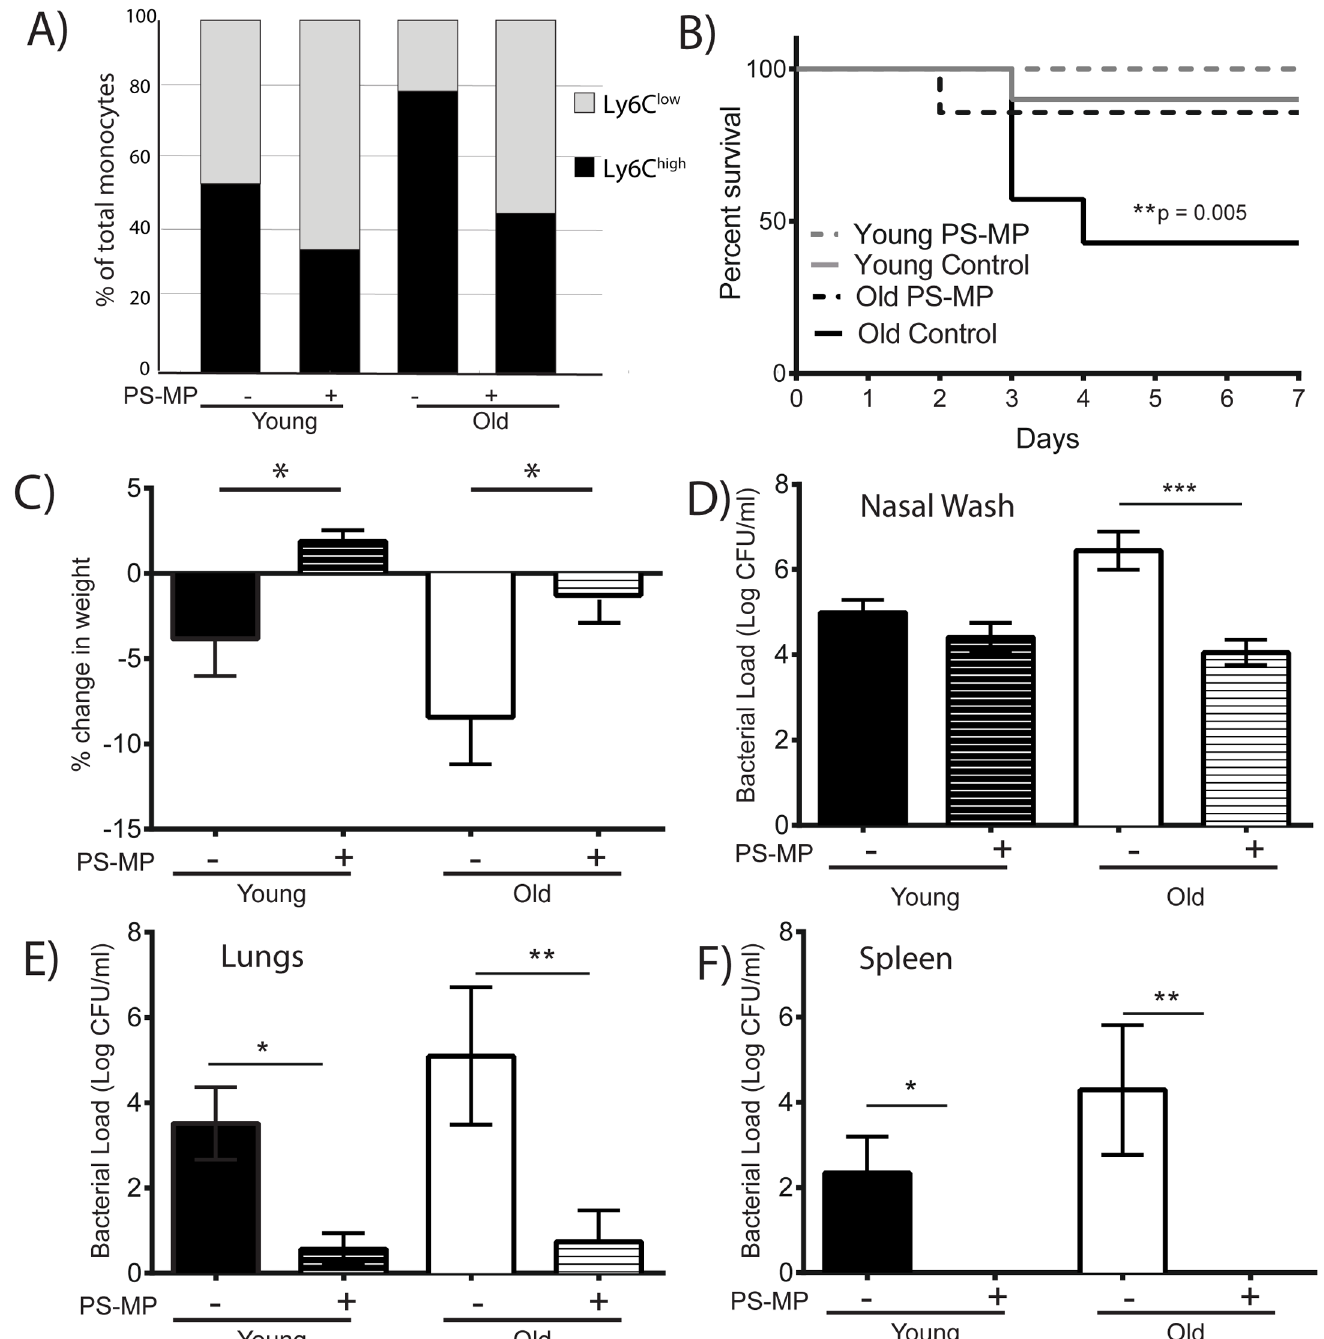
Fig 8. Depletion of inflammatory monocytes improves outcome to S. pneumoniae infection in old mice. Mice (n = 7-10/group) were injected with PS-MP day -1, 0, +1, +3 and +5 during colonization with S . pneumoniae . A) The percentage of Ly6C high monocytes was significantly reduced in old mice treated with PS-MP (see S3 Fig). B) Survival was significantly improved in old mice treated with PS-MP (p = 0.005, Mantel-Cox log-rank test). C) Both young and old mice treated with PS-MP lost less weight than their control counterparts ( * ,p < 0.05, one-way ANOVA with uncorrected Fisher's LSD). Levels of S . pneumoniae in the D) nasal wash, E) lungs and F) spleen were lower in old mice treated with PS-MP. Fewer young mice had bacteria in their lungs and spleens when they were treated with PS-MP. ( * ,p < 0.05, ** ,p < 0.005 one-way ANOVA with uncorrected Fisher's LSD). CFU count for mice that reached endpoint before day 7 are not